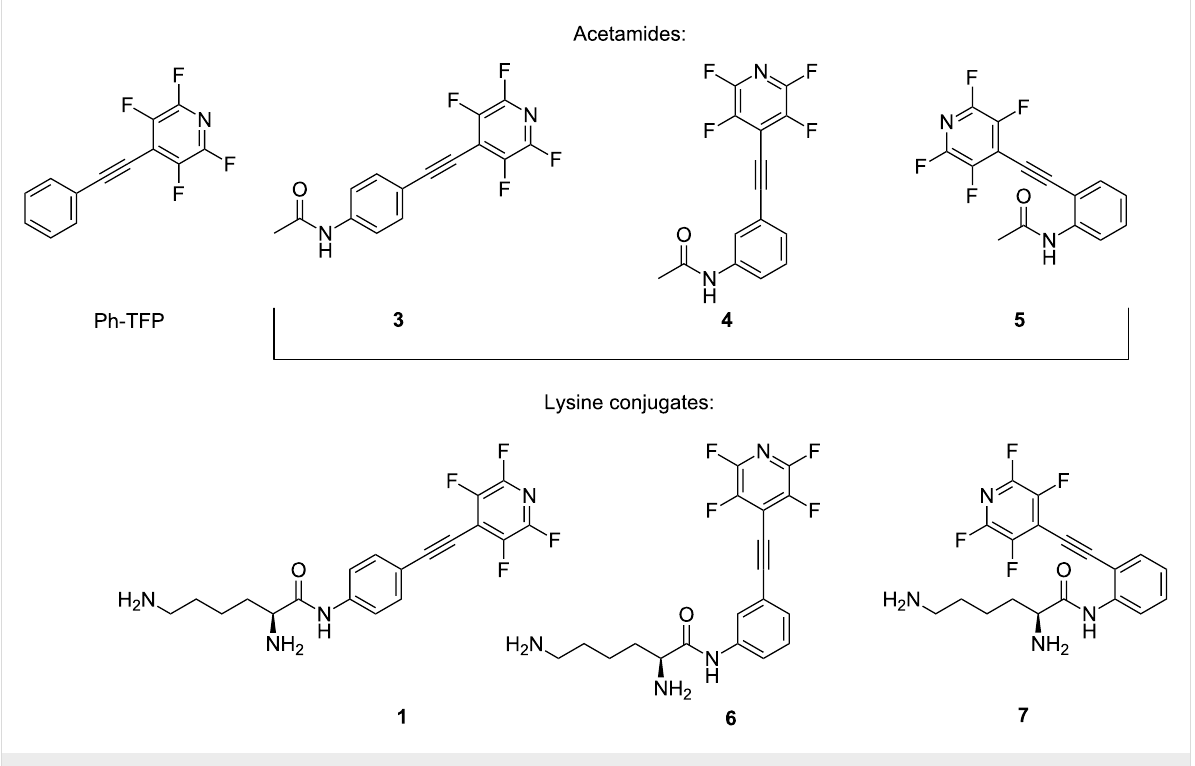
Figure 4: p -, m -, and o -amidyl acetylenes and respective lysine conjugates.